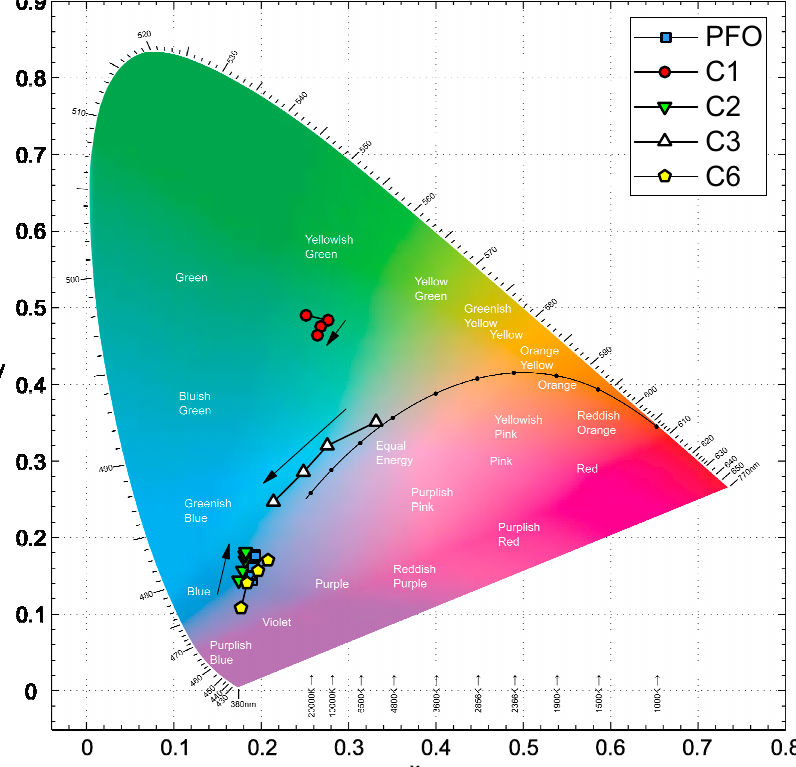
Figure 9. Chromaticity of C1, C2, C3, C6, and PFO devices. The increase of applied voltage (indicated by the black arrow) shifts the emission region.